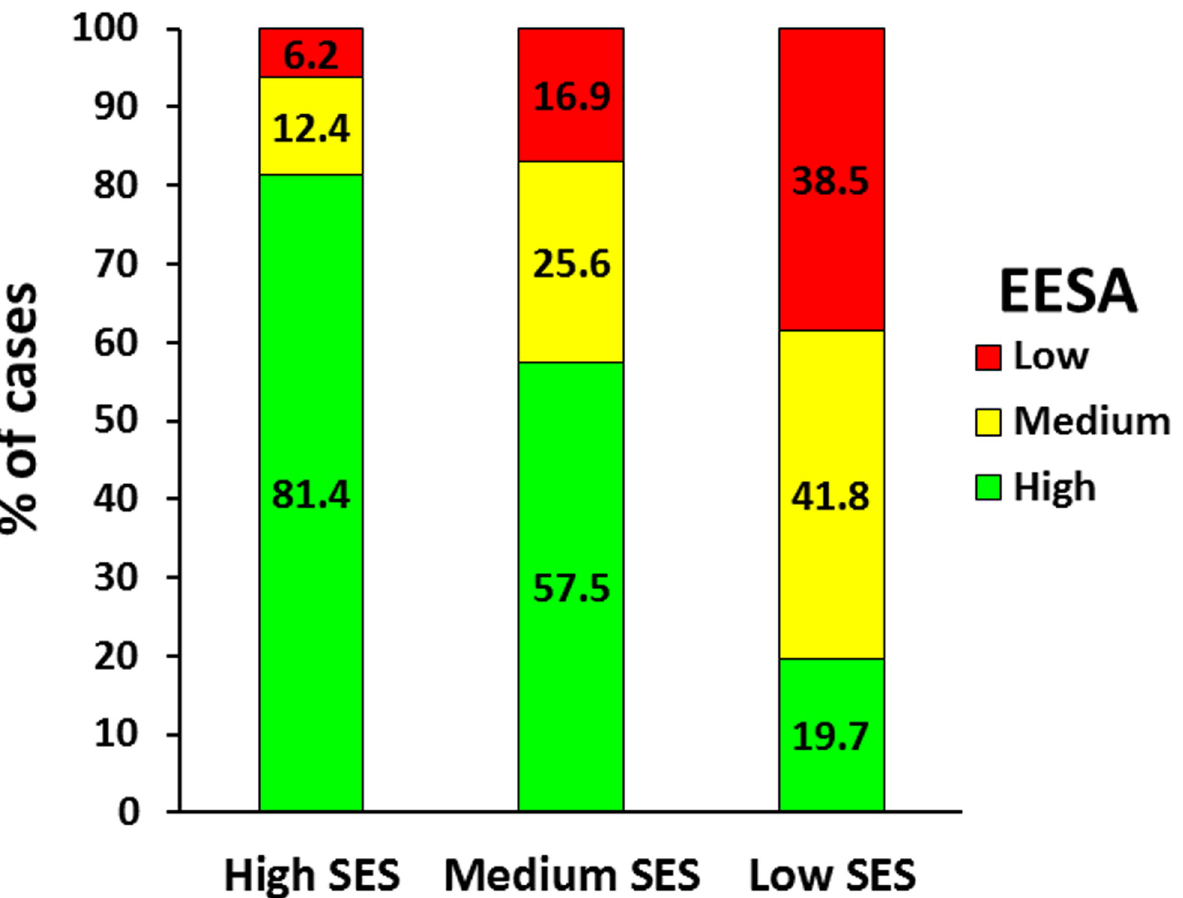
Fig 3. Distribution of the sample by the level of scholastic achievement of the educational establishments (EESA) in the 2009 SIMCE tests and socio-economic status (SES). ( n = 1,353). X 2